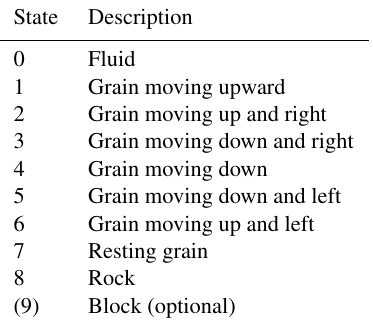
Table 1. States in the Grain Hill